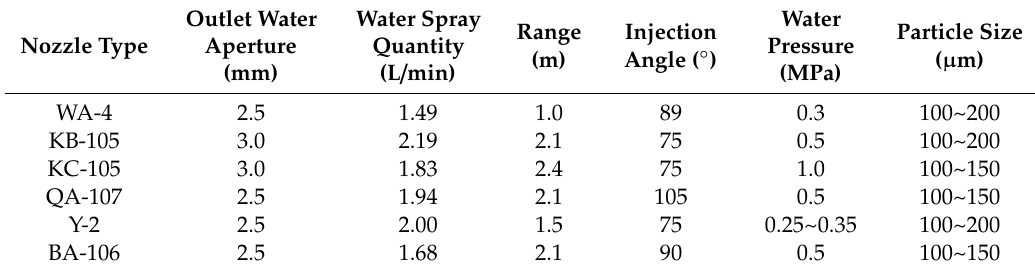
Table 2. Performances of experimental nozzles.